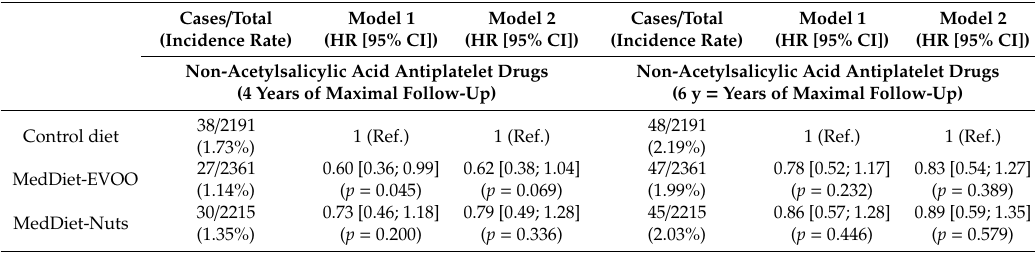
Table 4. Incidence of new users of non-acetylsalicylic acid antiplatelet drugs. Cases / Total (Incidence Rate)